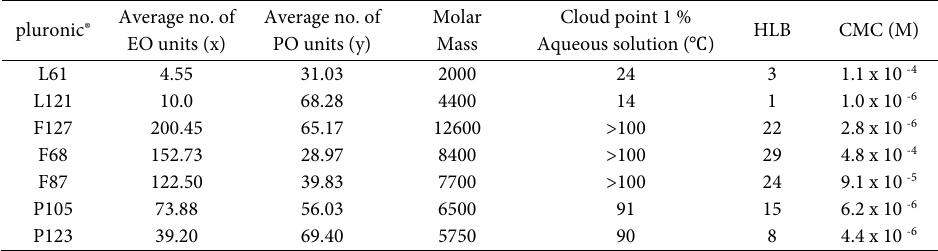
Table 1. physicochemical characteristics of some of the Pluronic® block copolymers [33]. Average no. of Average no. pluronic® EO units (x)